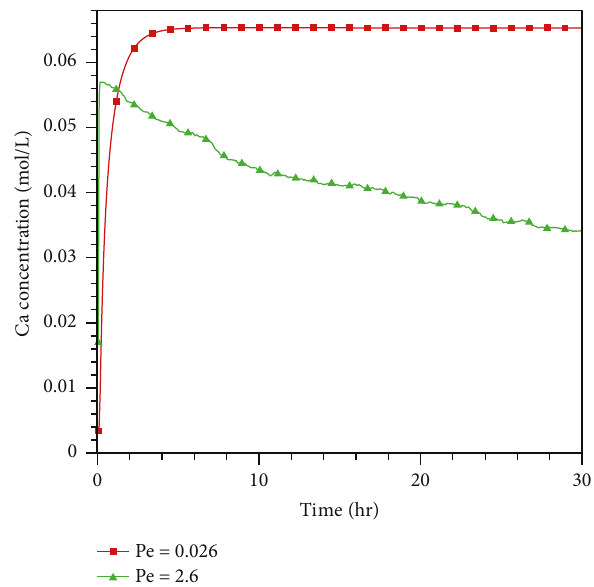
Figure 18: Normalized permeability versus normalized porosity at two di ff erent Pe numbers for initially mixed mineral assemblage (multispecies case).